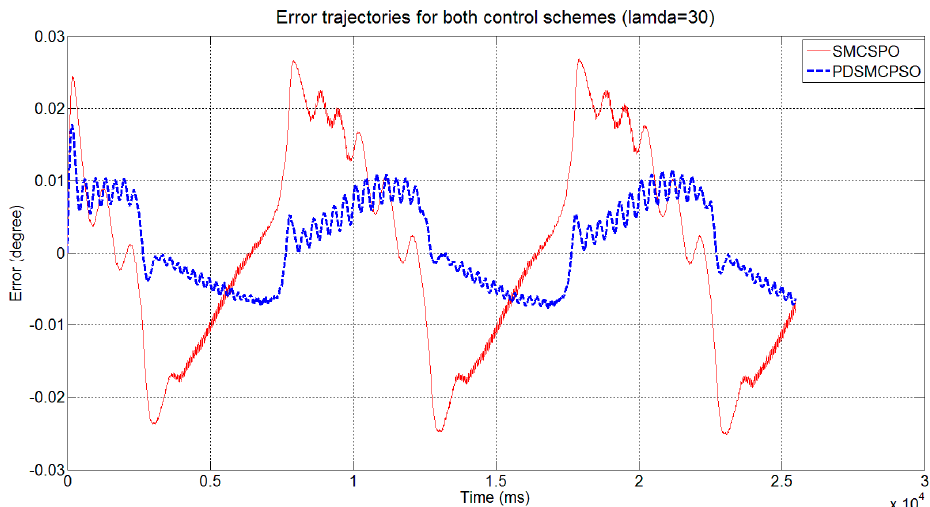
Figure 17. Error trajectories of both control schemes (lambda = 20).